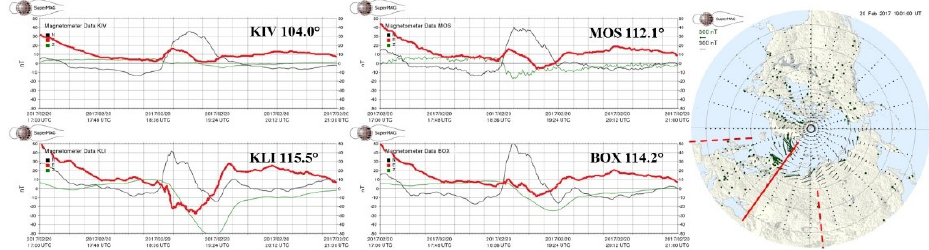
Fig.8. Examples of positive Y component (upper left panel), negative Y component (bottom left panel), and of cases, where Y passes through zero (middle panels). The Y component is marked by a thick line. The right panel presents the magnetic field vectors during the substorm (at 19:01 UT) by SuperMAG. The determined central meridian of the substorm is indicated by a continuous line, and the longitudinal boundaries of the positive bays extent – by dotted